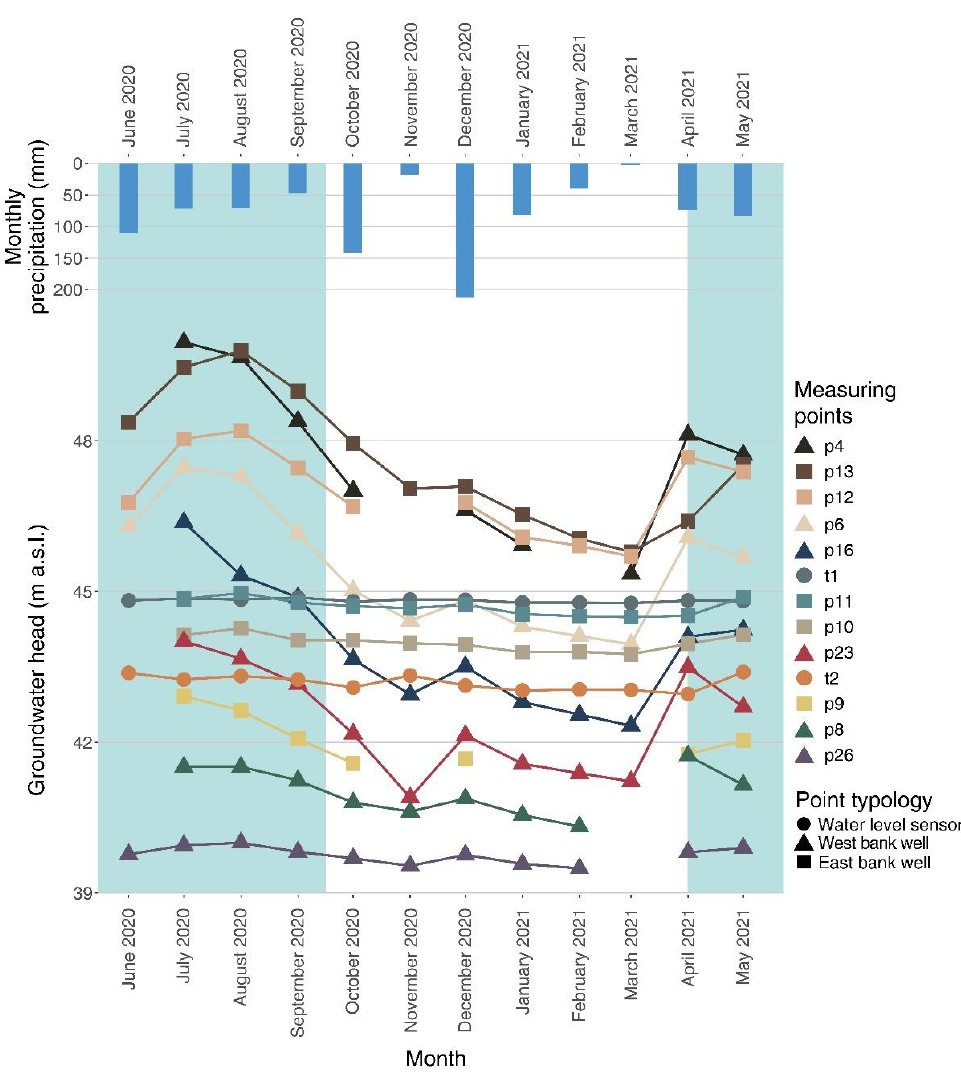
Figure 3. Groundwater level fluctuations in the monitored wells. The bar plot shows the monthly precipitation from the Goito meteorological station. The triangles represent wells in the west bank of the Mincio River, the squares those in the east bank, and the circles represent the water level sensors in the Mincio River. The shaded area includes the irrigation period. During this period, the highest hydraulic heads are reported (July 2020), whereas the recession period shows the lower hydraulic heads peaks in March, when the lowest groundwater heads were measured. The regression coefficients distribution in the study area highlighted two different zones. One is described by the wells near the Mincio River,